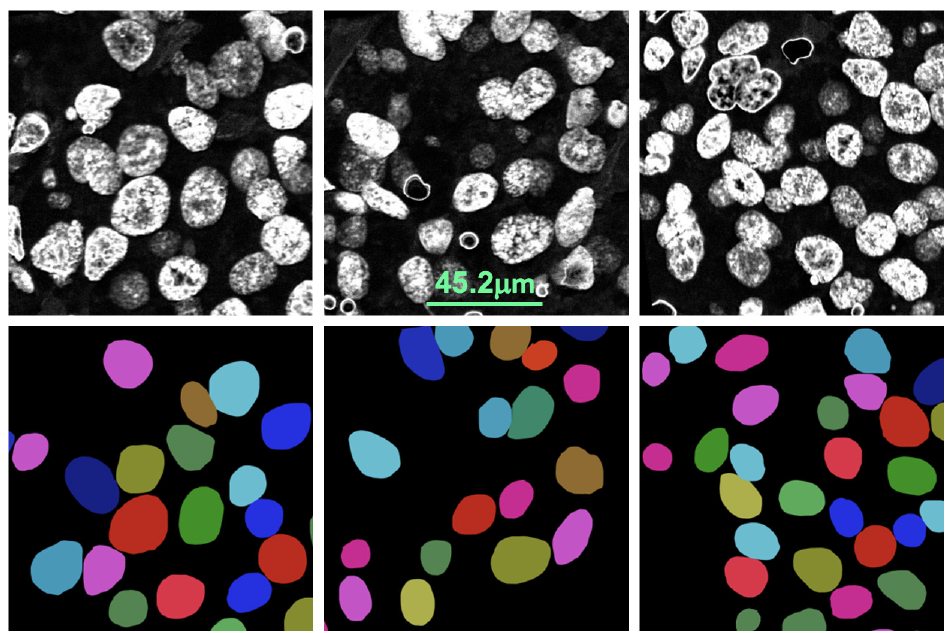
Figure 7. Examples of how the data were annotated. The top row shows the deconvoluted ver- sion of the original color images, and the bottom row shows the pathologist’s annotations for the corresponding